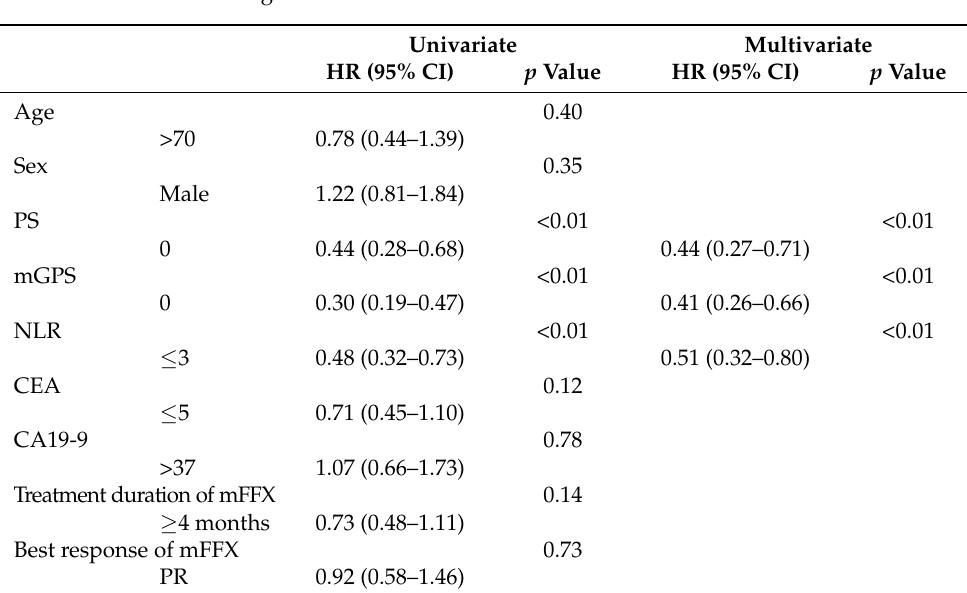
Figure 2. Overall survival from first-line treatment. OS, overall survival; CI, confidence interval. Table 4. Factors influencing overall